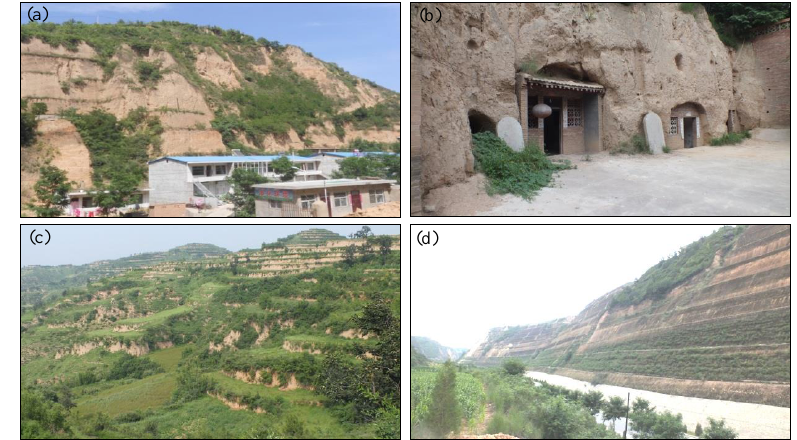
Figure 10. Typical engineering activities in loess areas in China: (a) cut slopes for buildings; (b) excavations for cave dwellings; (c) terraced fields for farming; and (d) cut slopes for highways.